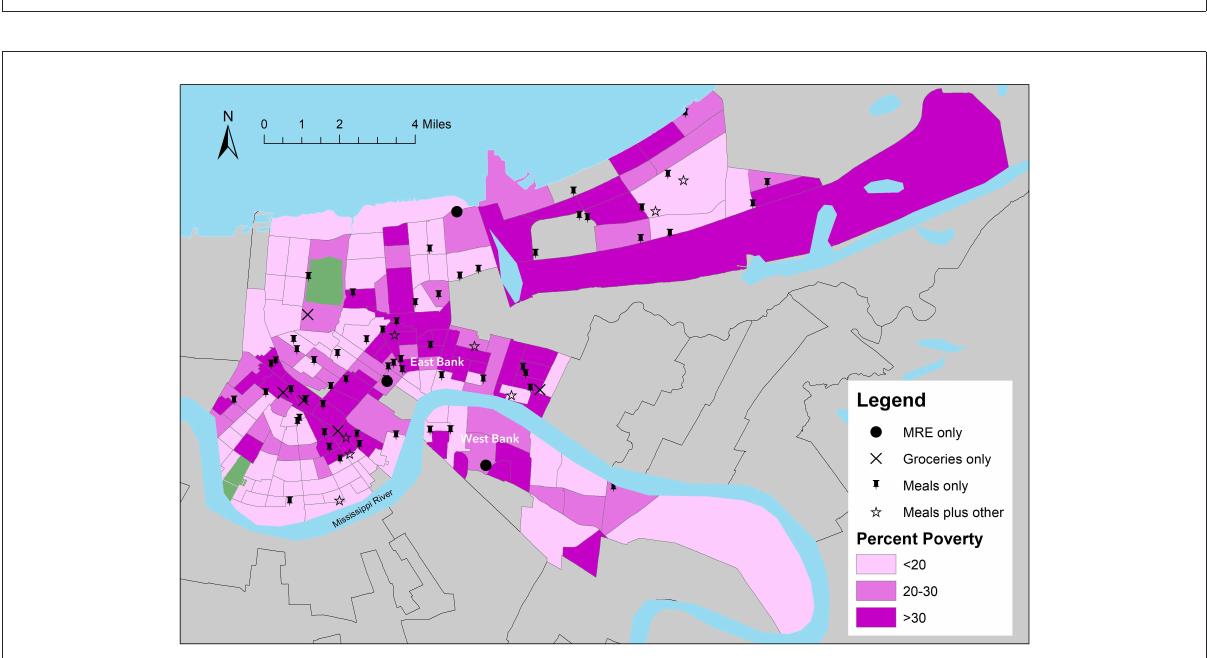
FIGURE3 Location of Emergency Food Distribution Sites in New Orleans Relative to Census Tract-Level Estimates for % Poverty. Data on sites locations provided by NOLA Ready , the city’s emergency preparedness office. Census tract-level estimates of % poverty were obtained from the U.S. Census Bureau (6,